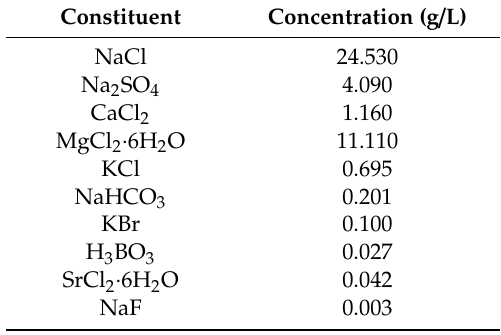
Table 2. Chemical composition of artificial seawater.